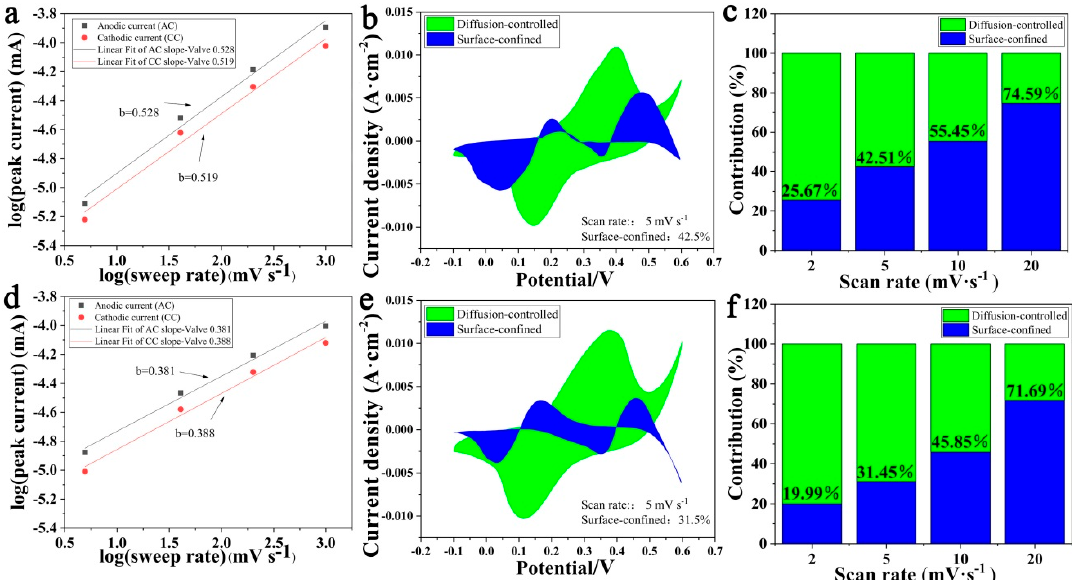
Figure 6. MHP bouquet arrays/ACF: ( a ) log(i p ) vs. log( ν ); ( b ) different contributions to charge storage: surface-confined (blue) and diffusion-controlled (green); ( c ) The ratios of diffusion-controlled contribution and surface-confined contribution at different scan rates. MHP nano-sheet arrays/ACF: ( d ) log(i p ) vs. log( ν ); ( e ) different contributions to charge storage: surface-confined (blue) and diffusion-controlled (green); ( f ) The ratios of diffusion-controlled contribution and surface-confined contribution at different scan rates.